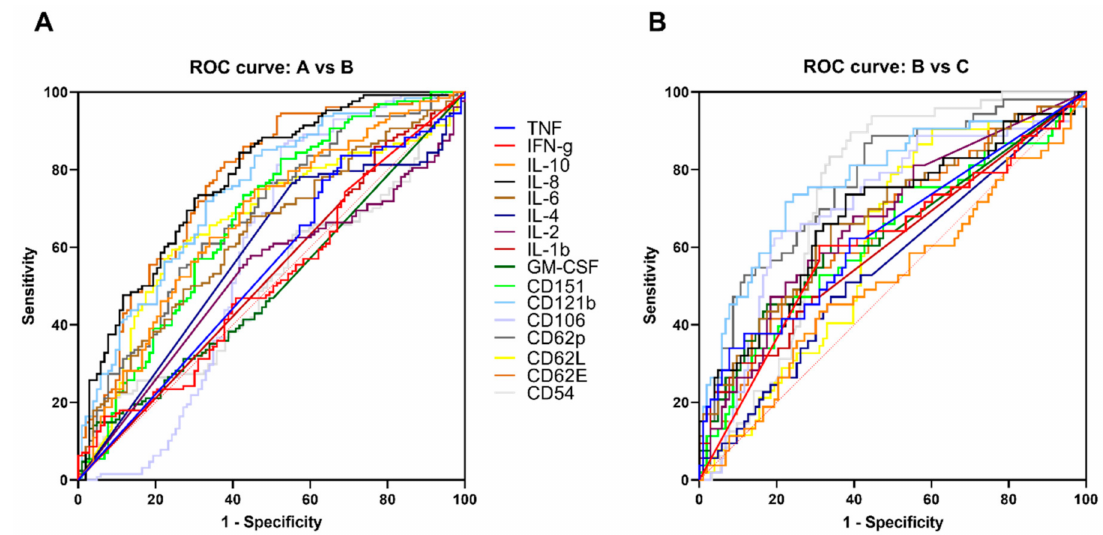
Figure 6. ROC curve of cytokines. Univariate logistic regression analysis was conducted. Performance of ROC curves of TNF, IFN-g, IL-17A, IL-12p70, IL-10, IL-8, IL-6, IL-2, IL-2, IL-1b, GM-CSF, CD178, CD151, CD121b, CD106, CD62P, CD62L, CD62E and CD54 for predicting DENV severity and differentiating from dengue without warning sign symp-toms A, dengue with warning signs B and severe dengue C. Plots depict he tradeoff between sensitivity and speci-ficity. The closer the curve follows the left-hand border and the top border of the ROC space, the more accurate the test. ( A ) ROC curve compared between dengue without warning sign symptoms and dengue with warning signs. ( B ) ROC curve compared between dengue with warning signs and severe